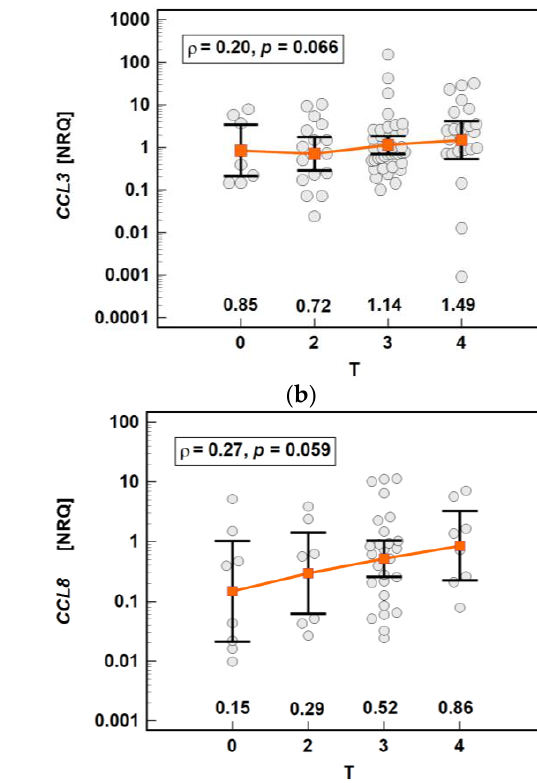
group differences are indicated by the same type of symbol: *, +, or ^. NRQ, normalized relative quantities.